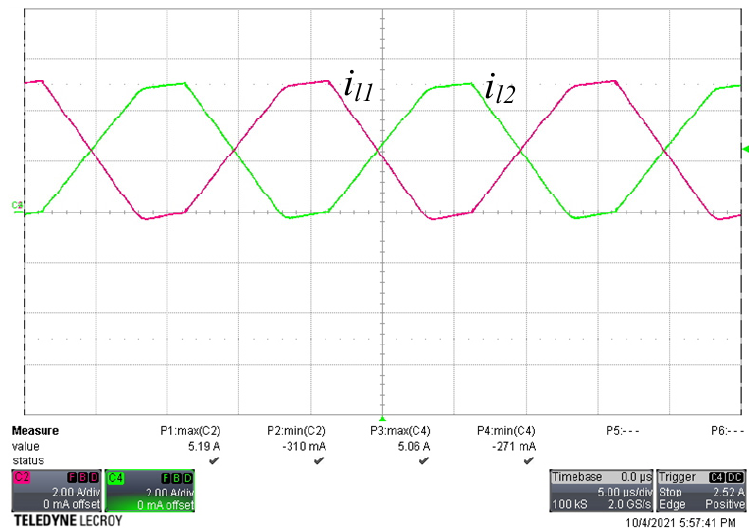
Figure 10. Current waveforms of the winding current of the coupled inductor ( i l 1 , i l 2 : 2A/div, time: 5 μ s/div).